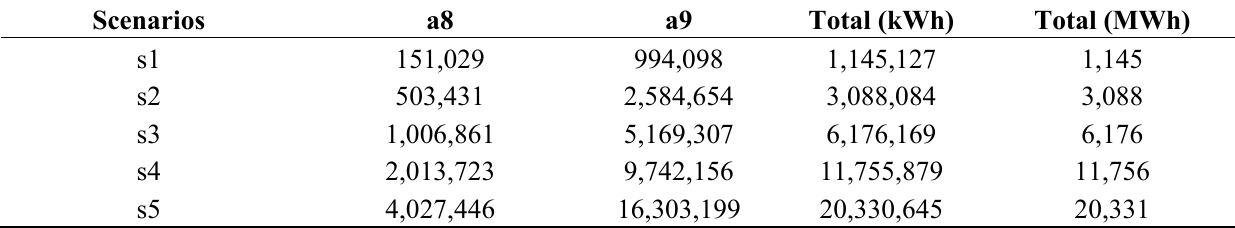
Table 9. Maximum potential for thermal and PV solar